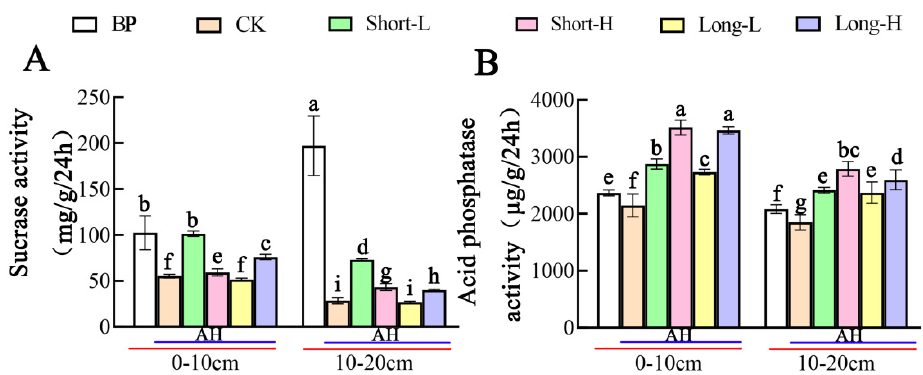
Figure 5. Variation trends of enzyme activities in different soil layers under different straw mulching treatments. Short, 10 cm wheat straw by mechanical cutting; Long, wheat straw without any treatment. BP, before planting; AH, after harvest; CK, soil layer without any treatment; L, 11,250 kg/ha straw mulching; H, 18,750 kg/ha straw mulching. ( A ), the sucrase activity of the soil; ( B ), the acid phosphatase activity of the soil. Data are means ± SD (n = 3). The different lowercase letters in the figure indicate significant differences between the different treatments based on the bidirectional ANOVA tests ( p <